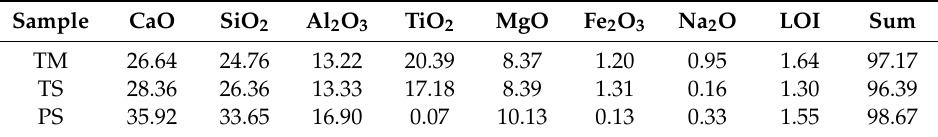
Table 1. Chemical composition of slag